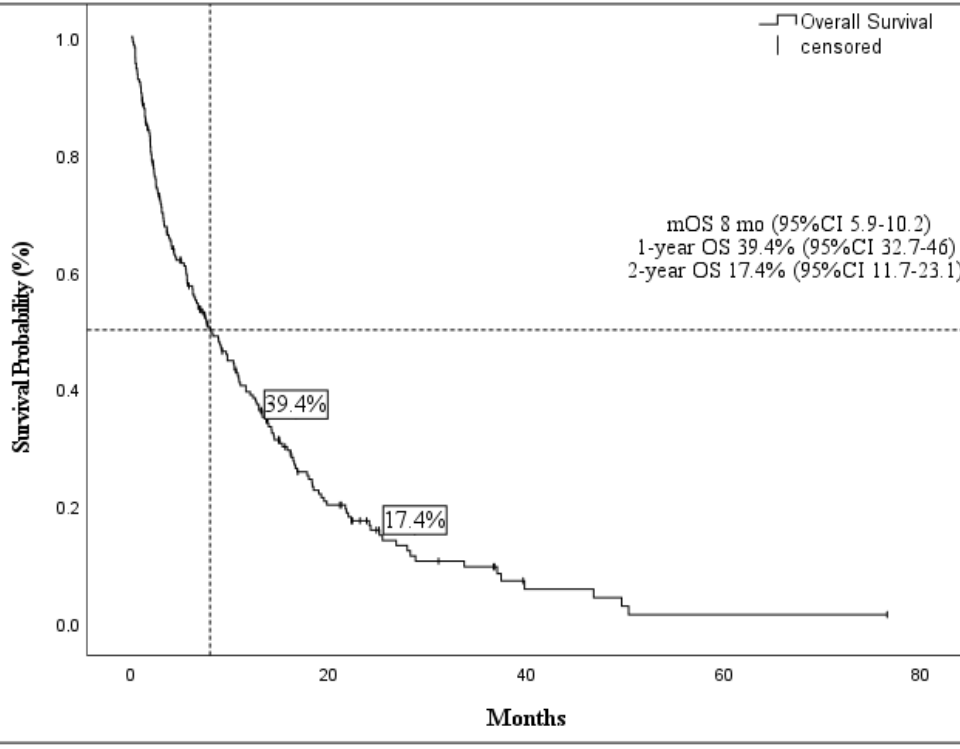
Figure 1. Median overall survival and 1- and 2-year overall survival of the entire cohort. Table 2. Results of Kaplan–Meier overall survival and event-free survival analysis.